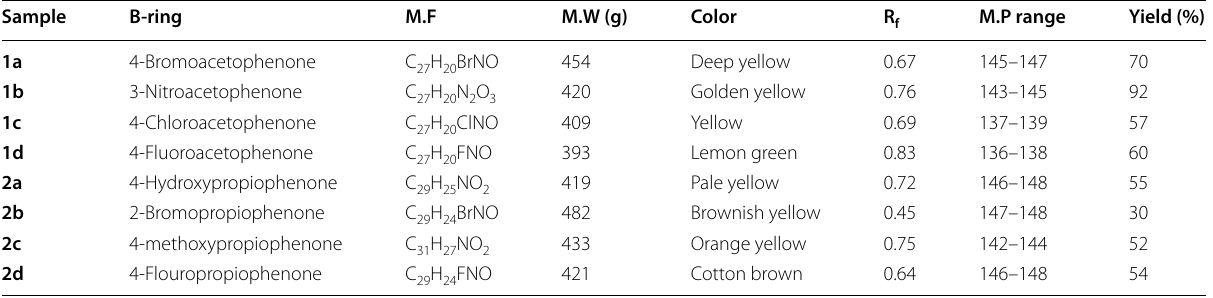
Table 1 Physical data of the synthesized triphenylamine chalcones Sample